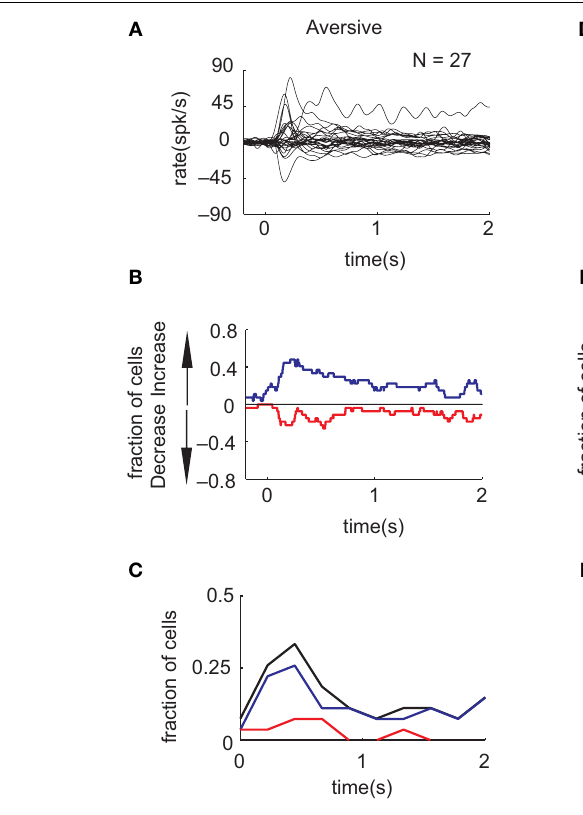
FIGURE 4 | The temporal pattern of SNpr neural responses to new cues after saturation of behavioral learning. (A) The PSTHs of the responses to the new cues predicting aversive outcome superimposed for all cells. For this analysis we used only responses after the 50th presentation of the new cue and excluded cells with fewer than 20 new trials. PSTH were smoothed with a Gaussian window with SD = 20 ms and the rate baseline was subtracted to enable comparison between responses. (B) The fraction of SNpr neural responses that showed a signifi cant (2 σ rule) increase (blue) or decrease (red)